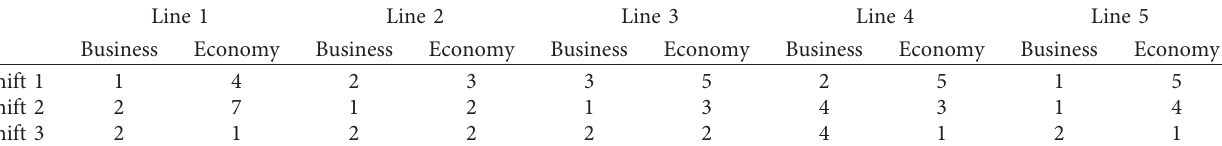
Table 5: Check-in additional resource results using local